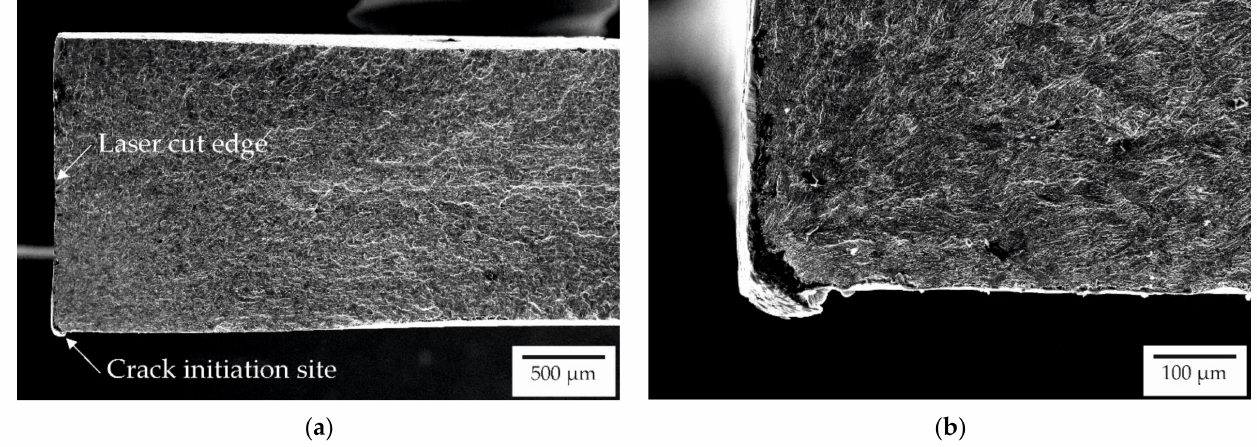
Figure 8. Fracture surface analysis of an as-cut specimen: ( a ) overview; ( b ) crack-initiating site at the burr of the laser-cut